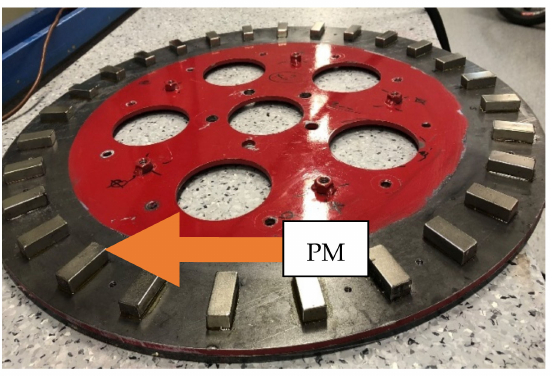
Figure 6. Rotor disc.